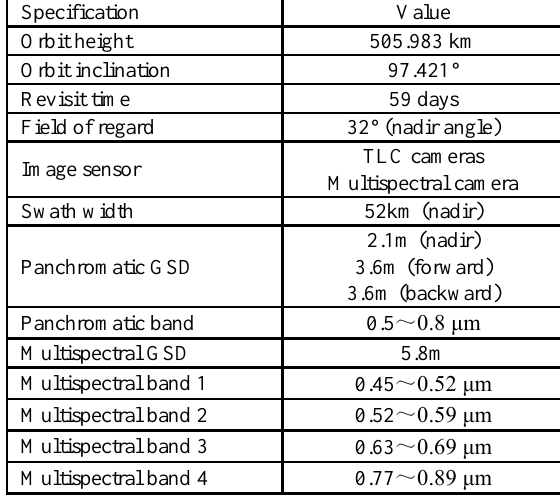
Table 1. Parameters of ZY-3 satellite